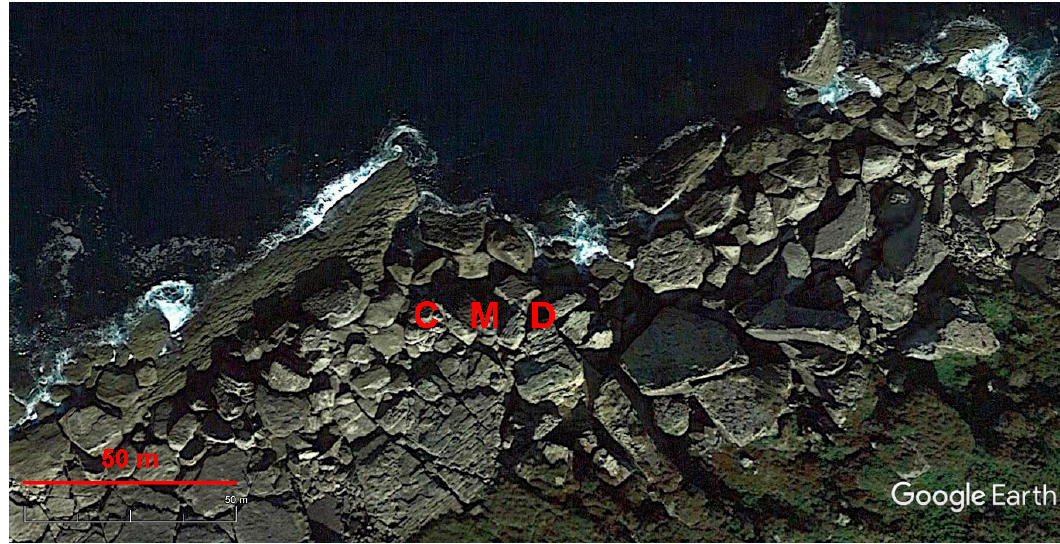
Figure 3. The western plot of the Hondarribia locality (the view provided by the Google Earth Engine).